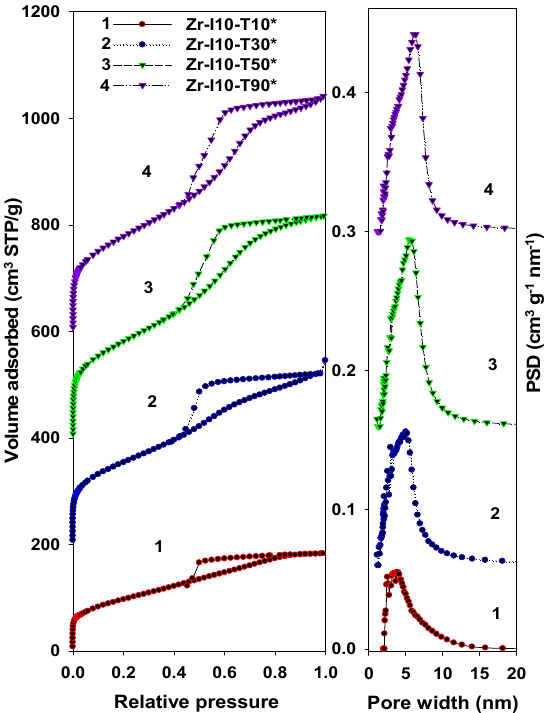
Figure 5. N 2 ‐ adsorption isotherms ( left panel ) and corresponding PSD curves ( right panel ) for Zr ‐ I10 ‐ TX*; isotherms 2, 3, and 4 are shifted by a multiple of 200 cm 3 STP/g. PSD curves are shifted by